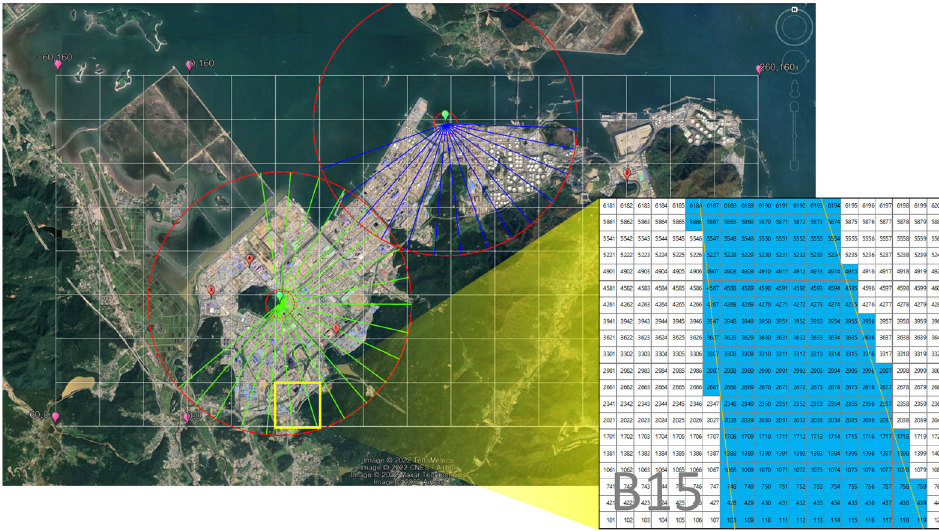
Figure 7. The monitored sections and sample of cell numbers corresponding to the section (B15).